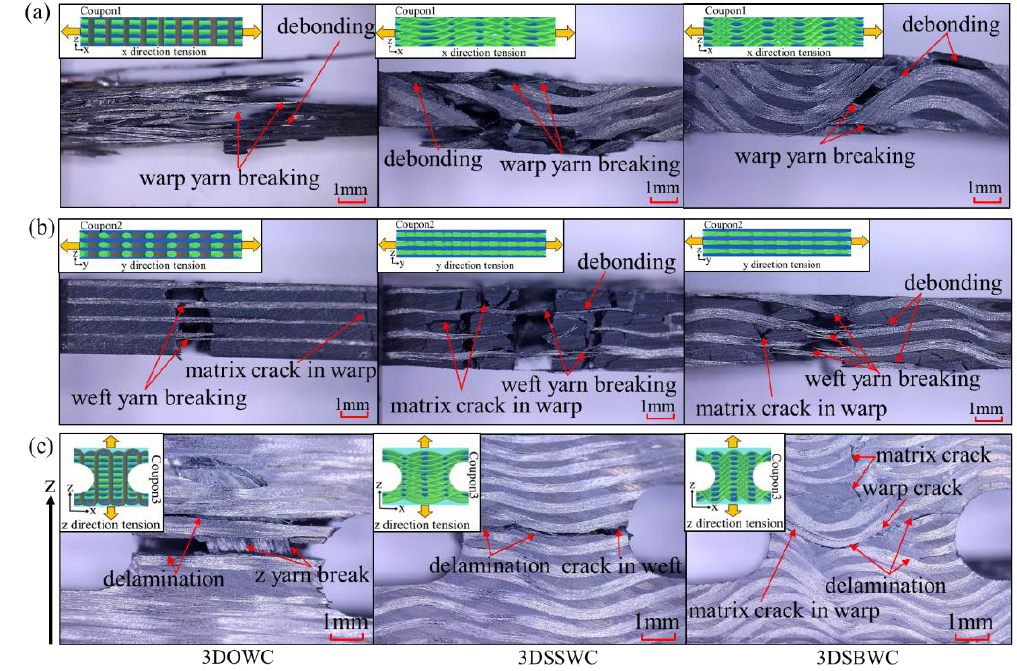
Figure 5. The tension failure mode in ( a ) the x-direction, ( b ) the y-direction, and ( c ) the z-direction.